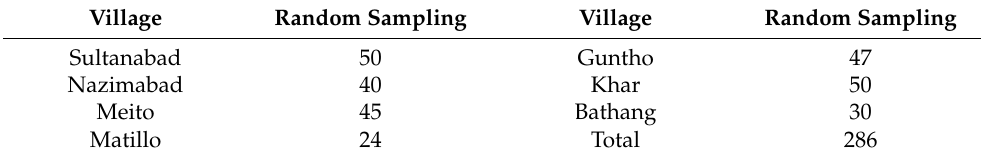
Table 2. Respondent random